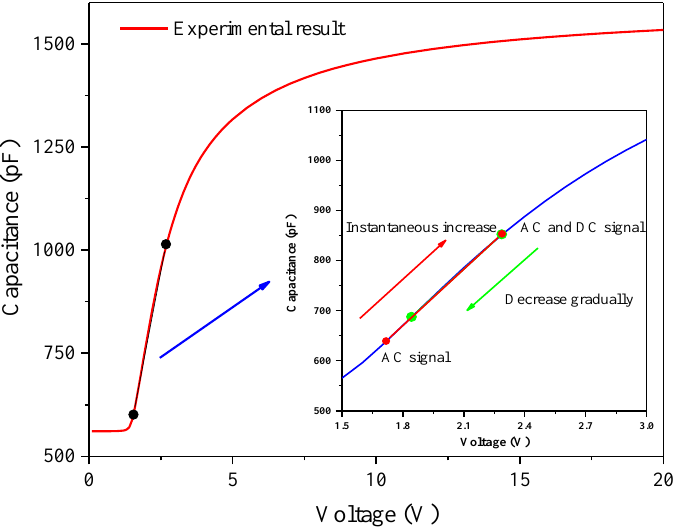
Figure 4. Capacitance of the LC cell varies with the voltage and the principle of evaluating residual direct current (DC) voltage.